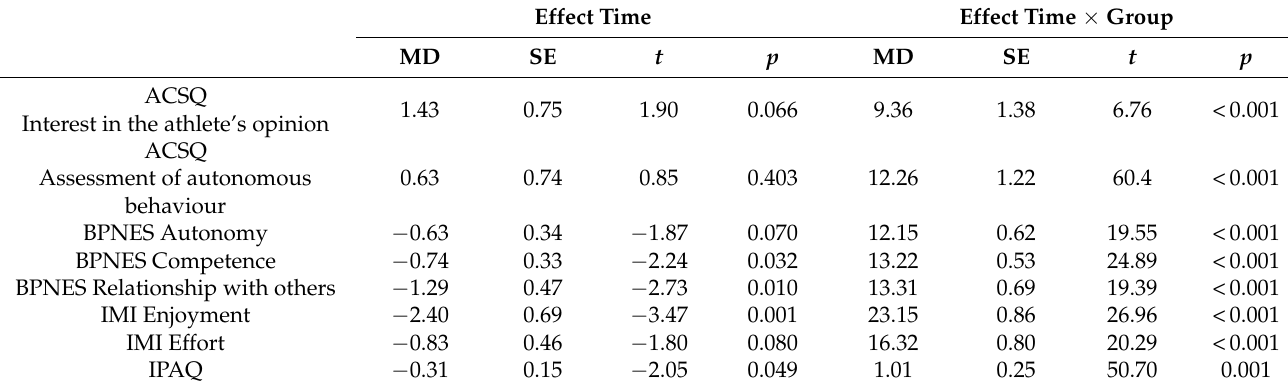
Table 2. Comparison characteristics at baseline and post-intervention